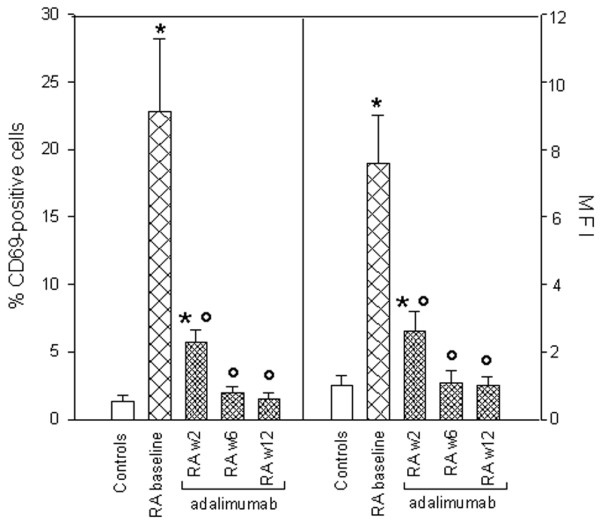
Modulation of CD69 membrane expression on neutrophils by adalimumab. Neutrophils, obtained as described in the legend to Fig. 1, were labelled with anti-CD69 mAb by indirect immunofluorescence. Results are expressed as mean ± standard error of the mean of percentage of positive cells (% CD69-positive cells) and as mean fluorescence intensity (MFI) corrected for nonspecific staining. *P < 0.001 versus controls; °P < 0.01 versus rheumatoid arthritis (RA) baseline